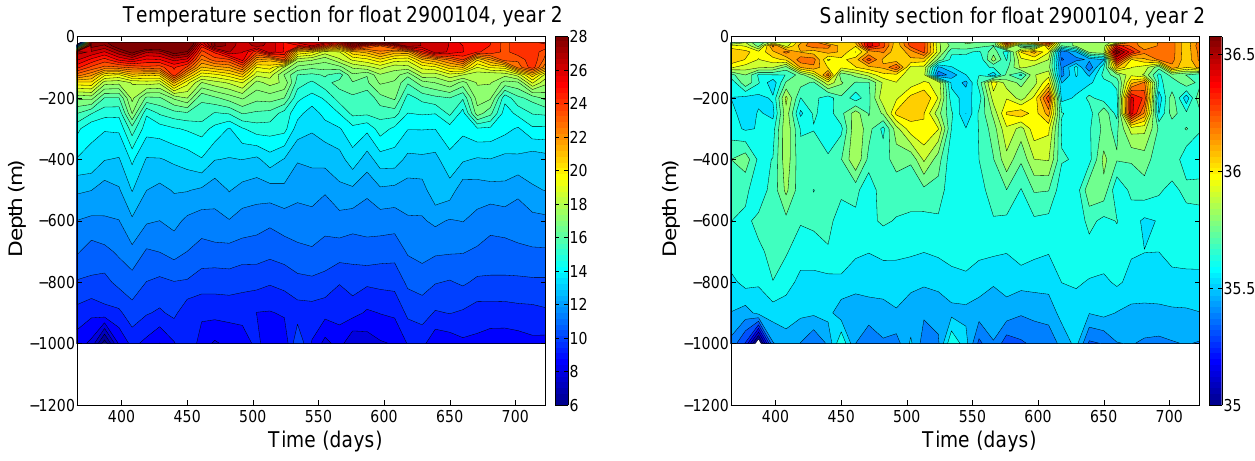
Fig. 17. Vertical sections of temperature (in ◦ C, left) and of salinity (right) along float 2900104 trajectory for year 2. Figure 17: Vertical sections of temperature (in o C , left) and of salinity (right) along float 2900104 trajectory for year 2.